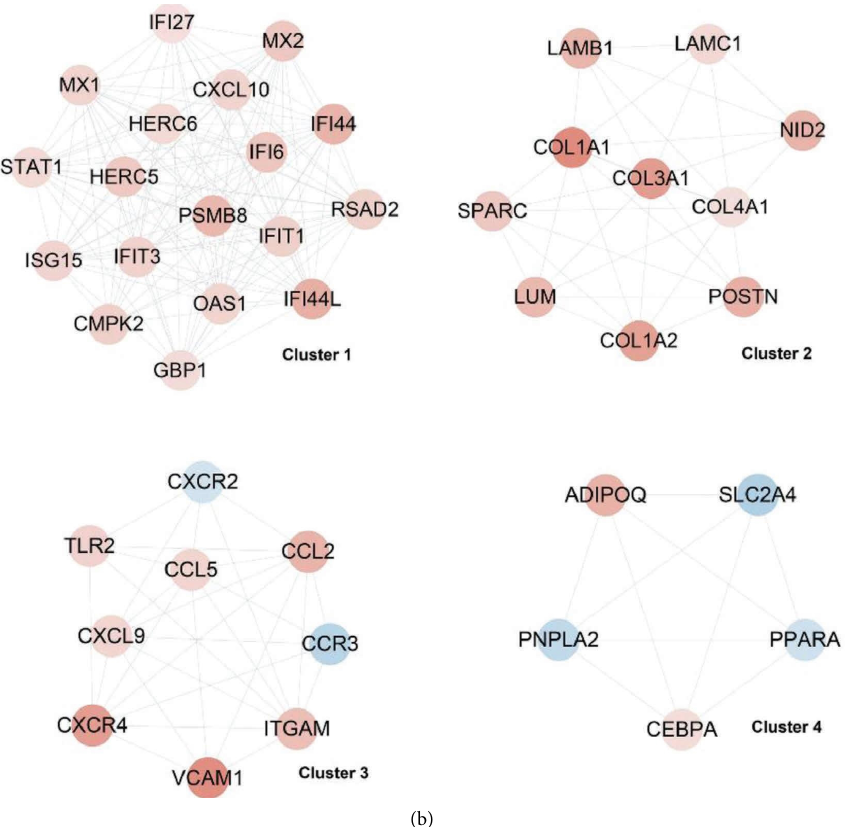
Figure 3: Construction of a protein-protein interaction (PPI) network based on the overlapping DMD-related DEMs. (a) A PPI network based on the DMD-related DEMs. A change in the color of the spots from blue to red indicates a change in the degree of signifcant diference from downregulation to upregulation. (b) Four network clusters extracted from the PPI network. Blue and red spots represent downregulated and upregulated proteins, respectively.